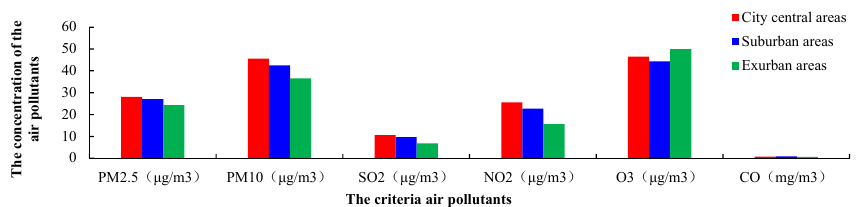
Figure 2. The average concentrations of the six criteria pollutants in three regional categories (city central areas, suburban areas and exurban areas) during Jan. 1 st 2015–Dec. 31 st 2016.